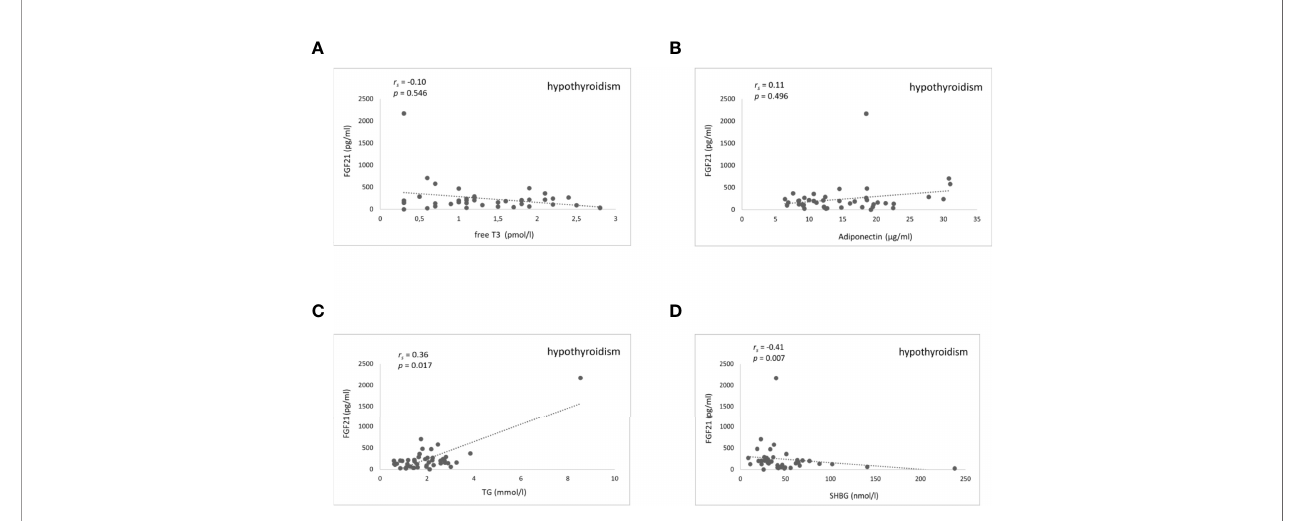
FIGURE 4 | Scatter plots showing FGF21 and fT3, adiponectin, triglycerides, and SHBG serum levels in hypothyroidism after RAI treatment. Relationship between serum FGF21 levels and fT3 (A) adiponectin (B) triglycerides (C) and SHBG (D) . FGF21, fi broblast growth factor 21; fT3, free triiodothyronine; TG, triglycerides; SHBG, sex hormone binding globulin. r s represents Spearman correlation coef fi cient. P<0.05 was considered signi fi